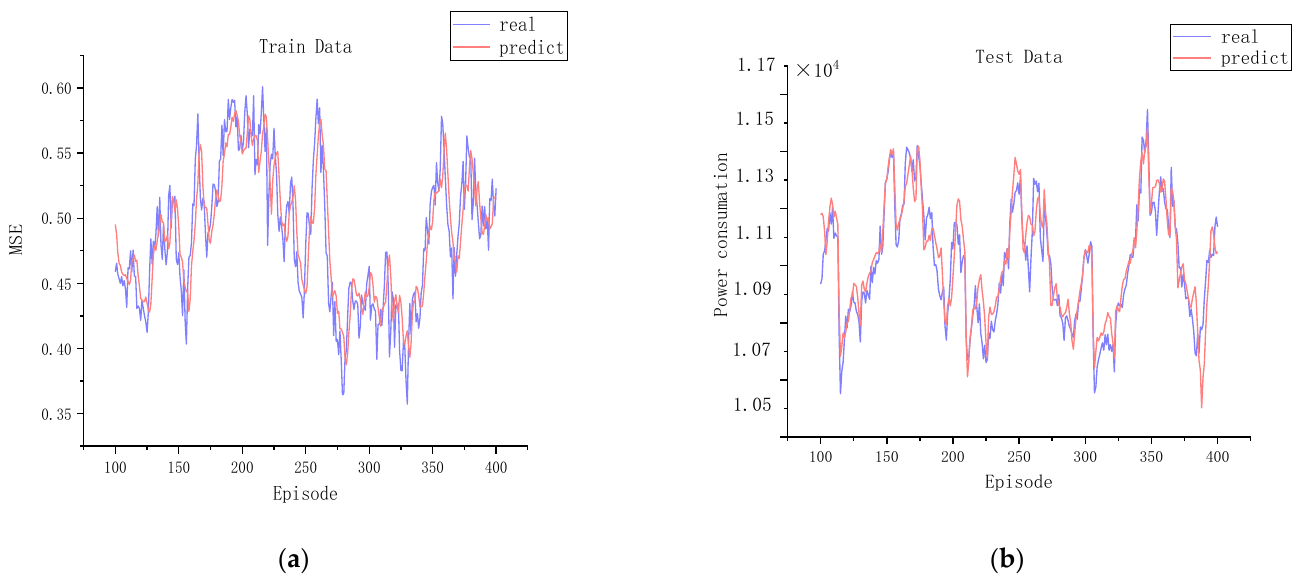
Figure 9. Neural network load prediction ( a ) power load training data error for a city in 2018 ( b ) power load prediction for a city in 2018.